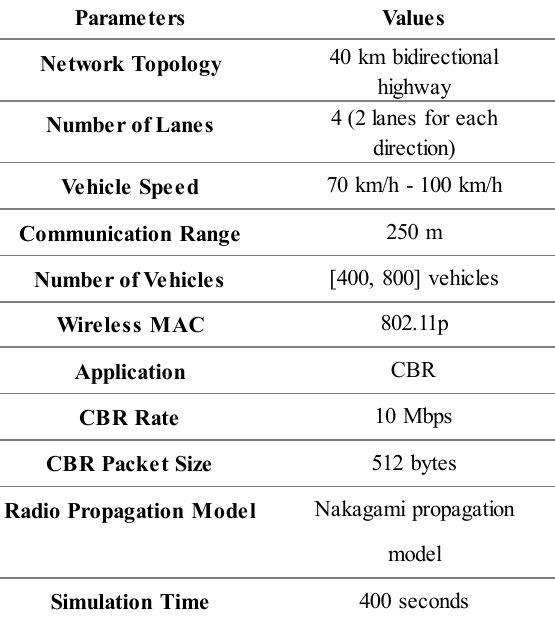
Table 2. Simulation